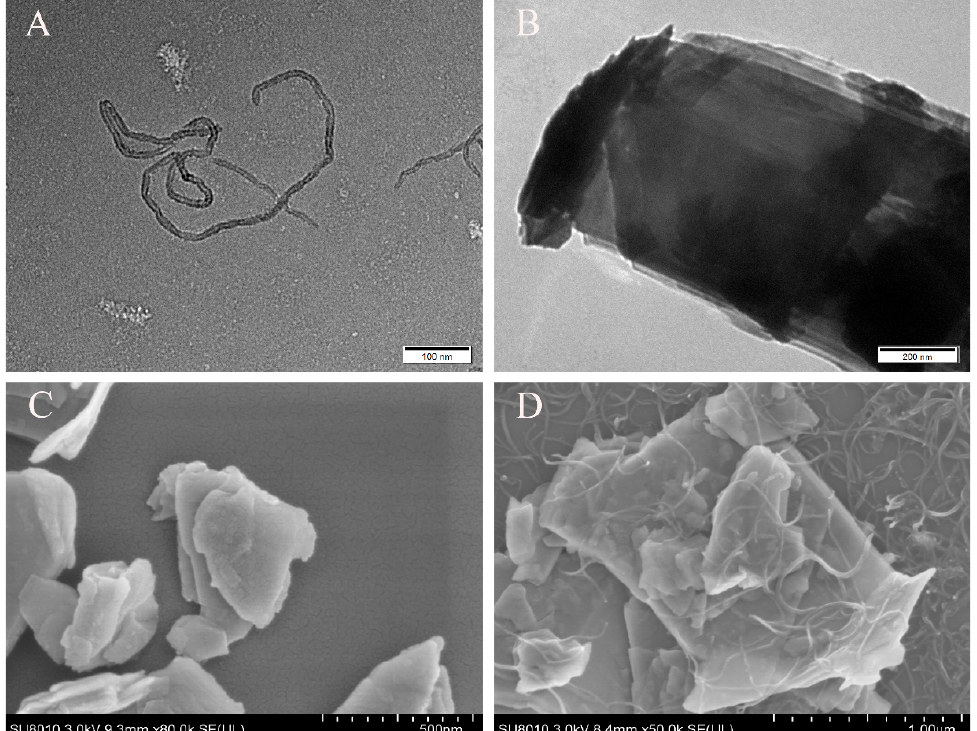
Figure 3. TEM images of MWCNT-COOH ( A ), MoS 2 ( B ), SEM images of MoS 2 ( C ), MoS 2 /MWCNT- COOH ( D ). COOH ( D